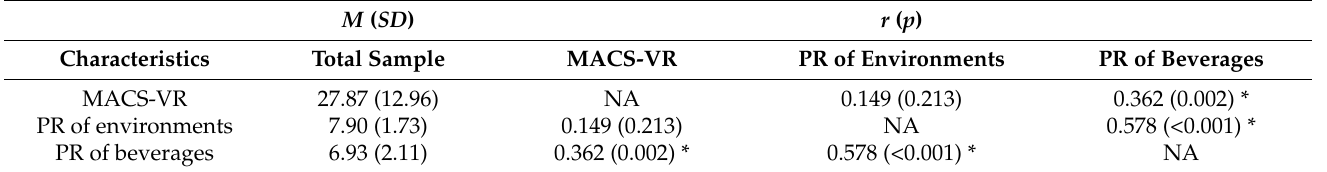
Table 3. Relationships between PR of environments, PR of beverages and